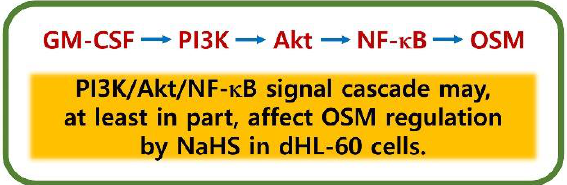
Figure 7. Schematic diagram of OSM suppression by NaHS. Supplementary Materials: The following supporting information can be downloaded at: https: //www.mdpi.com/article/10.3390/antiox12020417/s1, Figure S1: Neutrophil markers in HL-60 cells (DMSO: -) and differentiated HL-60 cells (DMSO: +). Figure S2: The OSM levels in dHL-60 cells and HMC-1 cells. Figure S3: OSM mRNA expression in dHL-60 cells. Figure S4: Phosphorylated levels of Akt and p65 in dHL-60